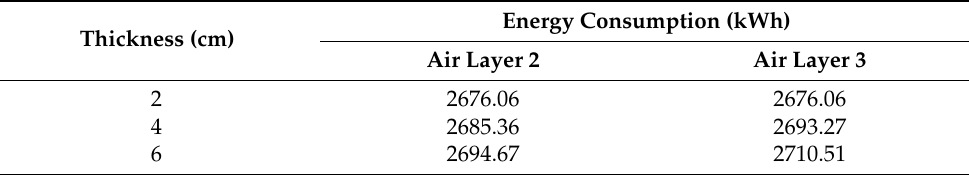
Table 4. The energy consumption of the room under different thicknesses of air